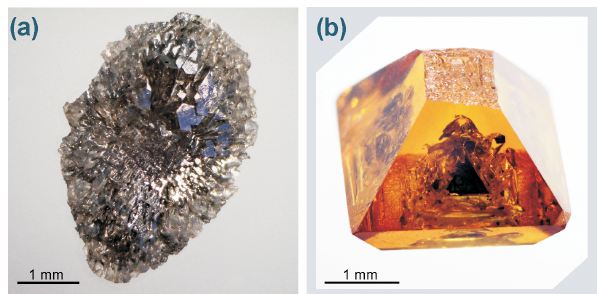
Figure 2. (a) General view of the carbon source residue after run 2– 41, which is a crystalline diamond aggregate; (b) diamond crystal weighing 0.5 carat from run 2–41, grown in the Fe–Ni–C system with 1wt% silicates added to the system (assembly configuration shown in Fig. 1a). The top of the crystal was in contact with the chamber wall and does not have faces. The crystal contains well- shaped inclusions of